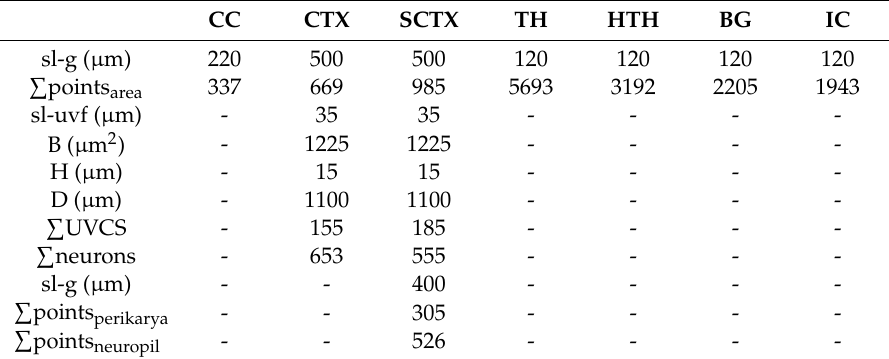
Table 1. Details of the stereological estimation